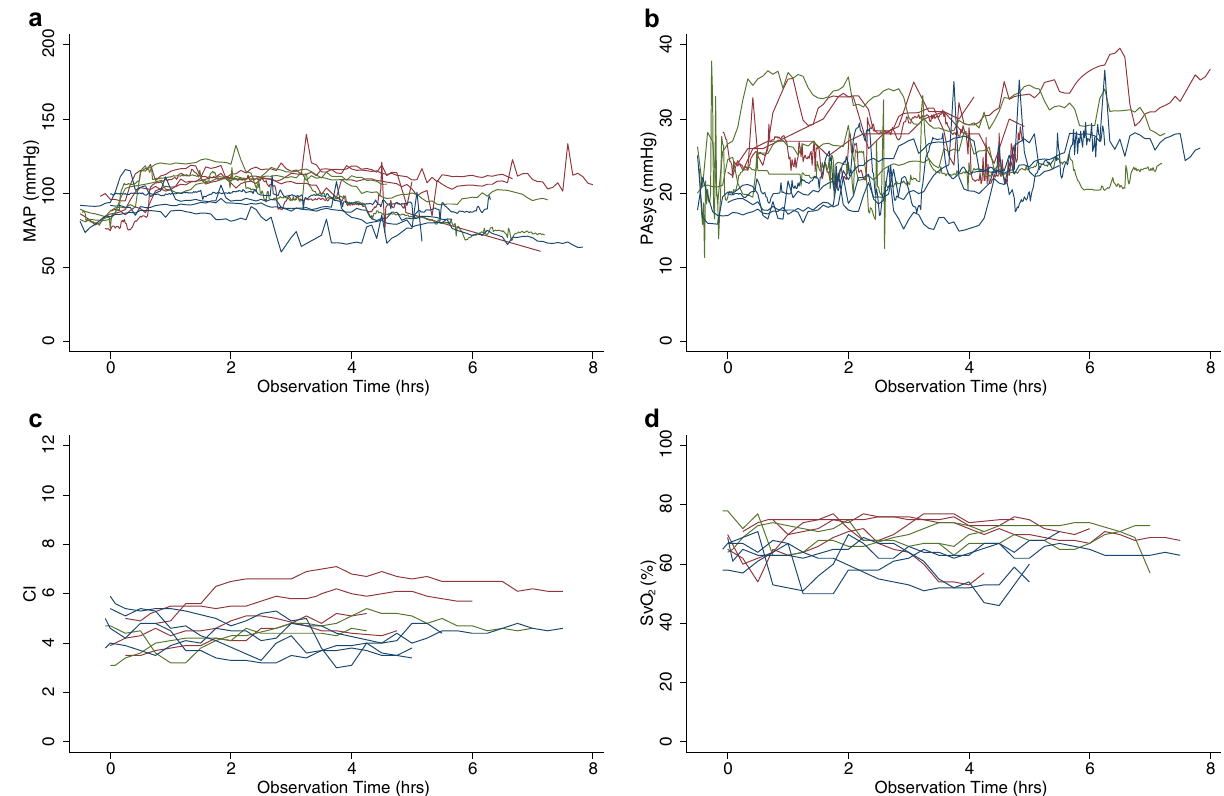
Fig. 4 Physiological measurements by groups across time. a Mean arterial pressure. b Systolic pulmonary artery pressure. c Cardiac index. d Mixed venous saturation. In all graphs, red represents individuals in the model group, blue represents individuals in the control group and, green represents individuals in the treatment group. Source data are provided as source data fi